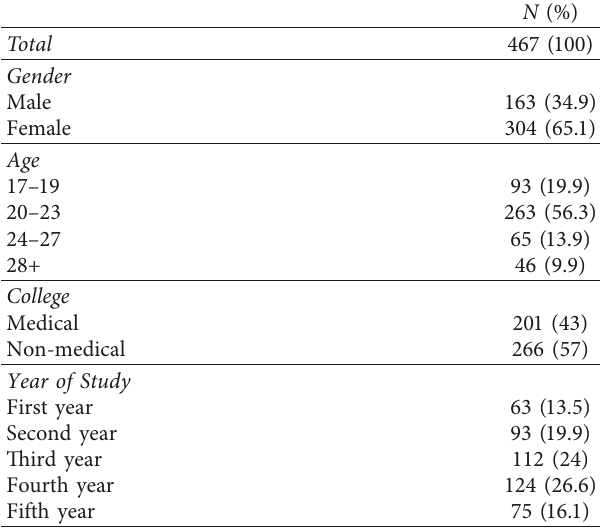
Table 1: Demographics of students ( n � 467).